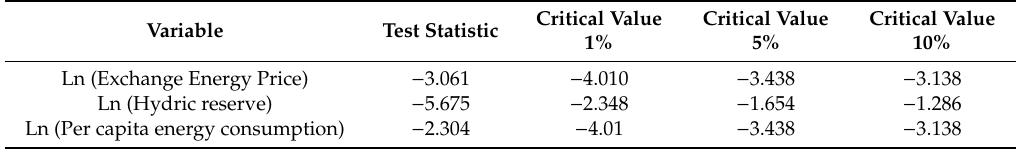
Table A3. Unit root test (ADF).